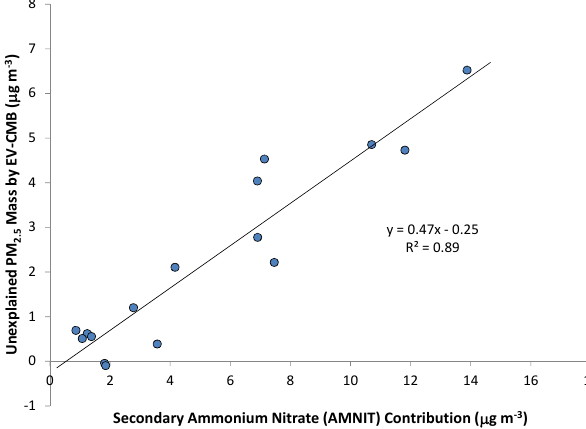
Fig. 9. Relationship between unexplained PM 2 . 5 mass and sec- ondary ammonium nitrate contribution by EV-CMB analysis. Four data points were excluded due to either missing levoglucosan mea-